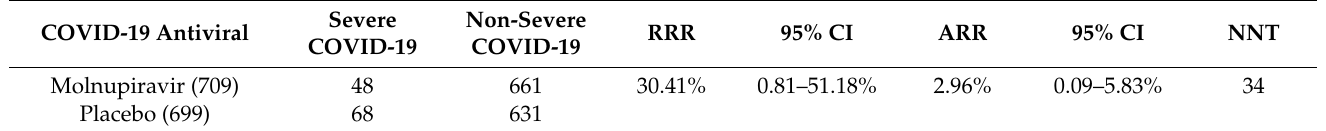
Table 4. Molnupiravir (lagevrio) MOVe-OUT trial data to prevent severe COVID-19 in